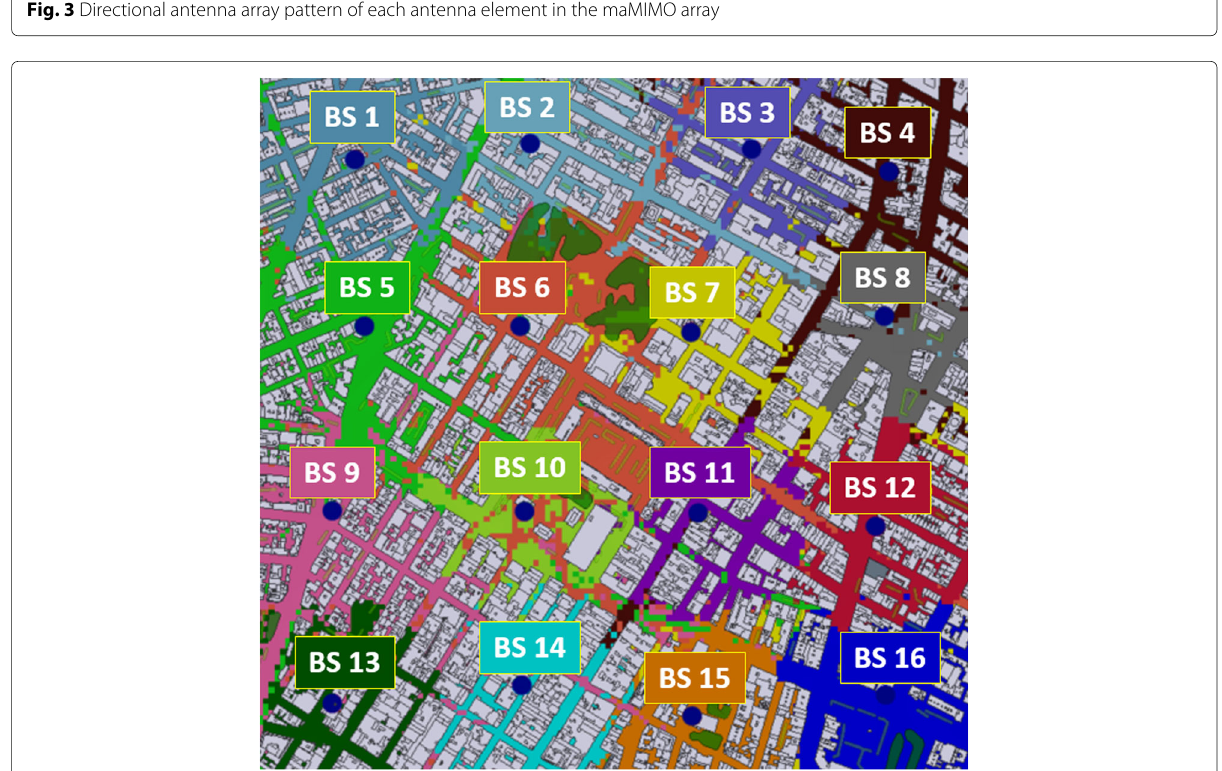
Fig. 4 Massive MIMO BS deployment area. The BSs are depicted by blue dots. The study area is 1.35 km 2 . The different colors in the streets represent the color corresponding to their best serving BS for that